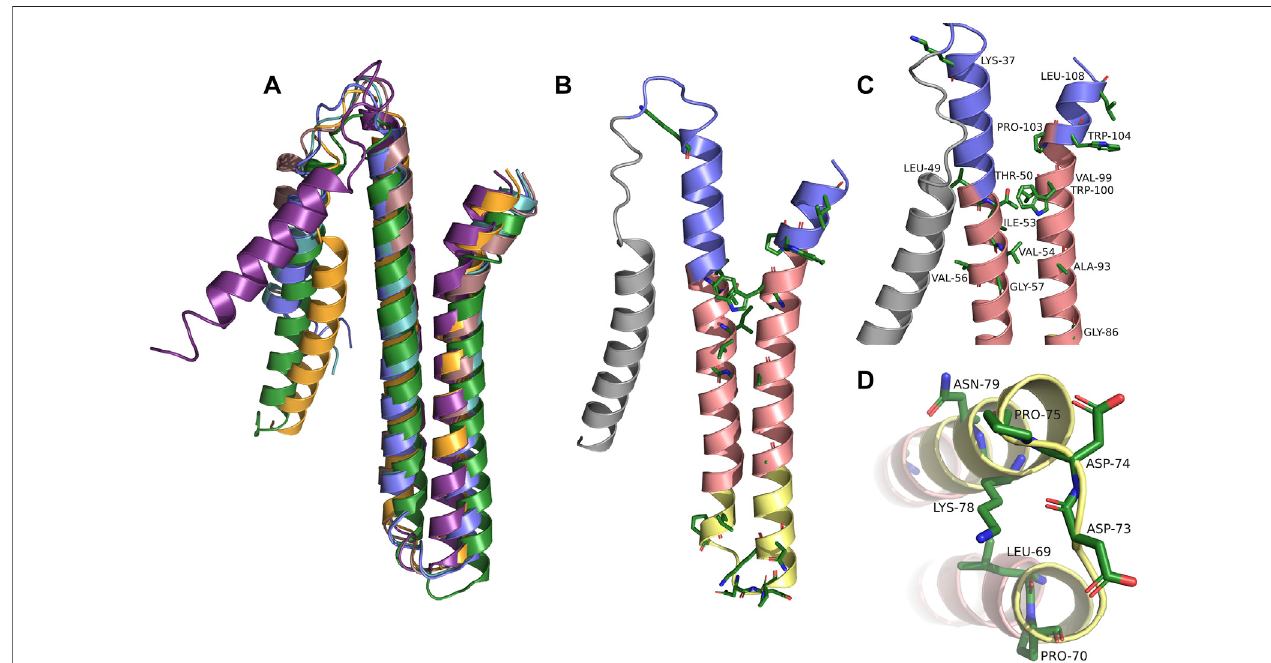
FIGURE3|(A) AlignmentofTraB pIP501 and its orthologs using thetheoreticalstructuresfrom Robetta. TrsB pAM β 1 and TrsB pRE25 were notincluded,becauseboth are 100% identical to TraB pIP501 . TraB pIP501 is shown in orange; the mating channel formation protein from pUCB11B is shown in purple; the CagC family protein from Staphylococcus aureus AF2236 is shown in rose; the CagC family protein from Clostridium algoriphilum DSM 16153 is depicted in green; TraB from Staphylococcus aureus 3688STDY6124879isshowninslate;TrsB pV030-8 isdepictedingreen-blue. (B) ShowsTraB pIP501 coloredaccordingtoitsorientationinthecellmembrane. The grey part representsthe secretion signal sequence;slate parts theextracellular part; the salmon parts are predicted to be within themembrane; the yellow parts are cytosolic.Aminoacids,whichareconserved inthemultiplesequencealignmentsareshowninstickpresentation. (C) and (D) ZoomintotheareasofTraB pIP501 showing the highest conservation. The conserved amino acids are shown as sticks and labeled. Same color scheme as in panel (B,C) Showing the details of the interface area between the cell membrane and the peptidoglycan layer. (D) Zoom into the cytosolic loop of TraB pIP501 , bottom